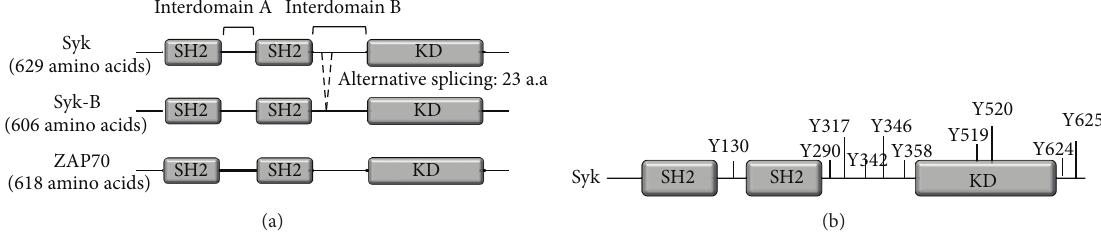
Figure 1: Biochemical features of Syk. (a) Structure comparison of Syk family kinases. (b) Phosphorylation sites of Syk.